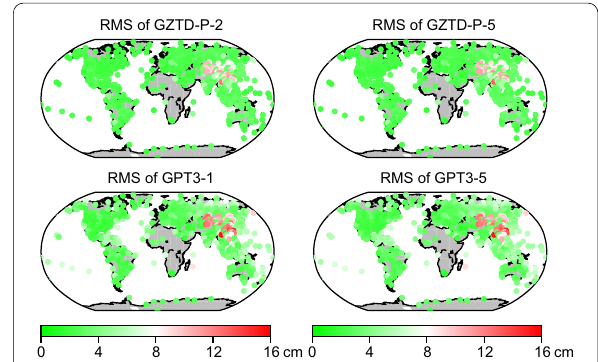
Fig. 10 RMS of the GZTD-P model and GPT3 model with different resolutions in the ZTD vertical interpolation of radiosonde over the